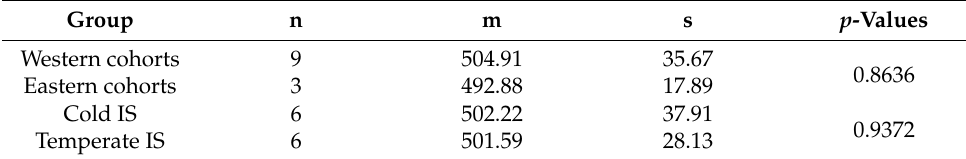
Table 6. Comparison of the mean (m) body mass with the standard deviation (s) in kg of the cohorts (n = number) of caballoid horses from the western and eastern part of France and from cold and temperate isotopic stages (IS) using the Mann-Withney statistical